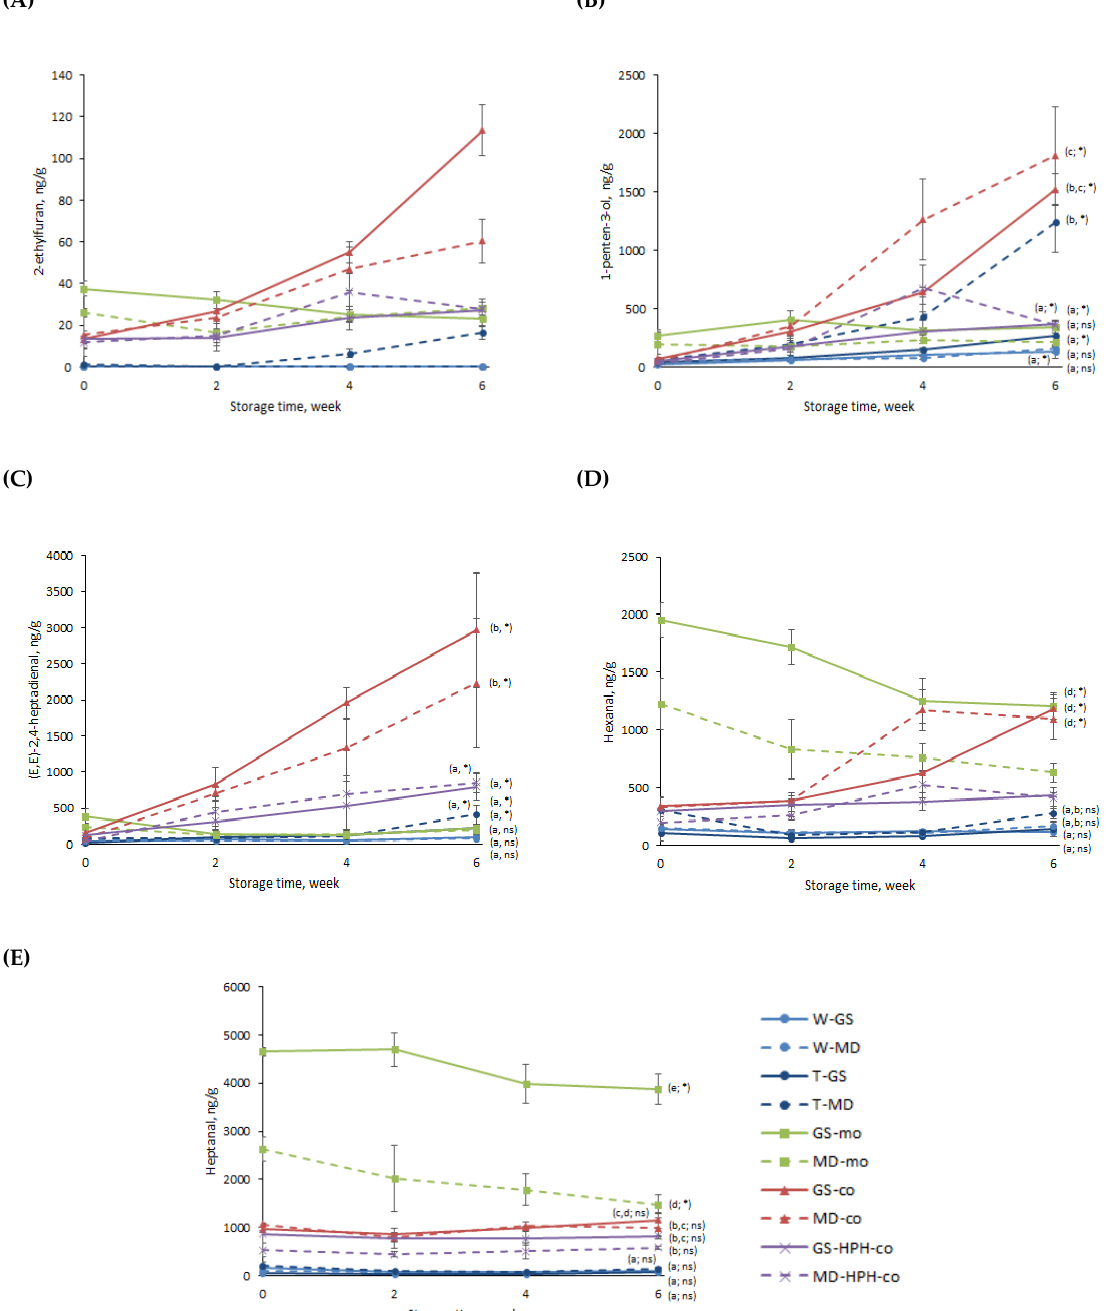
Figure 6. Secondary volatile oxidation products (SVOPs) of the fish-oil-loaded capsules produced by